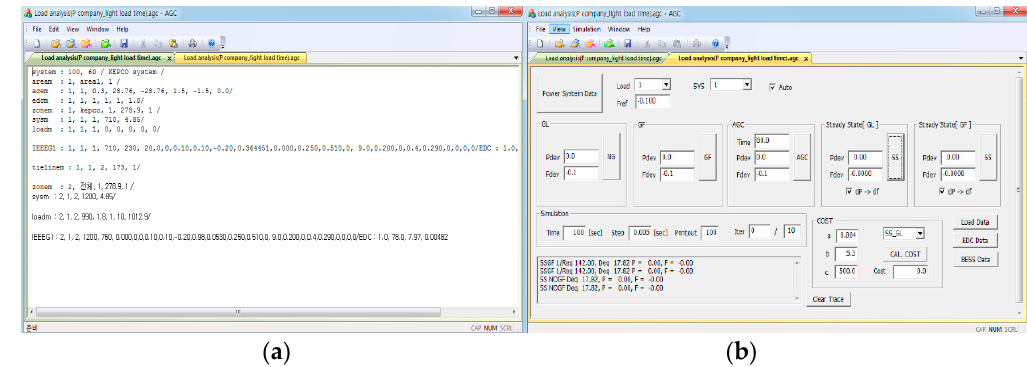
Figure 8. Developed AGC program: ( a ) Input tab of the model data; ( b ) Tab of the set and run.